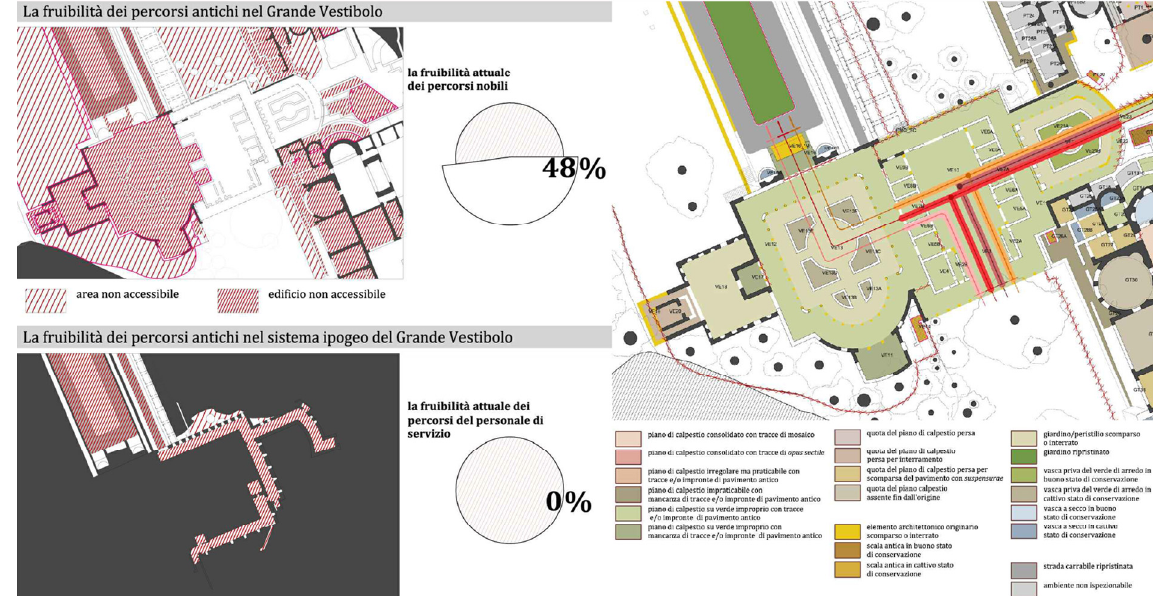
Figure 6. Usability of the Grand